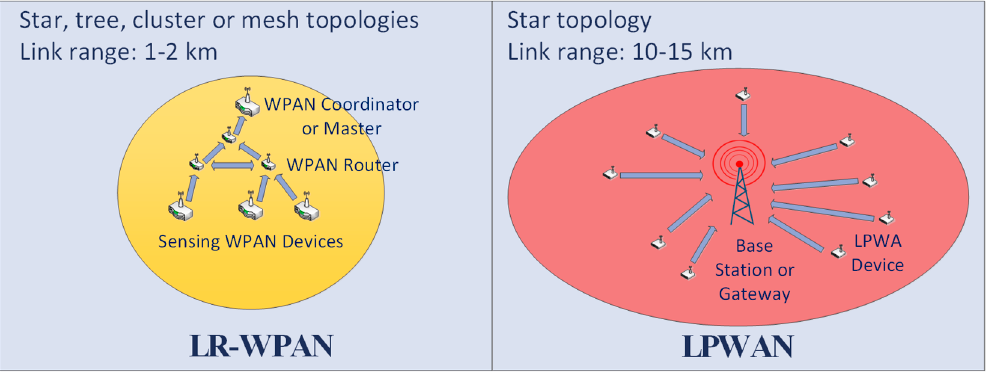
Figure 1. Network evolution from LR-WPANs to LPWANs.